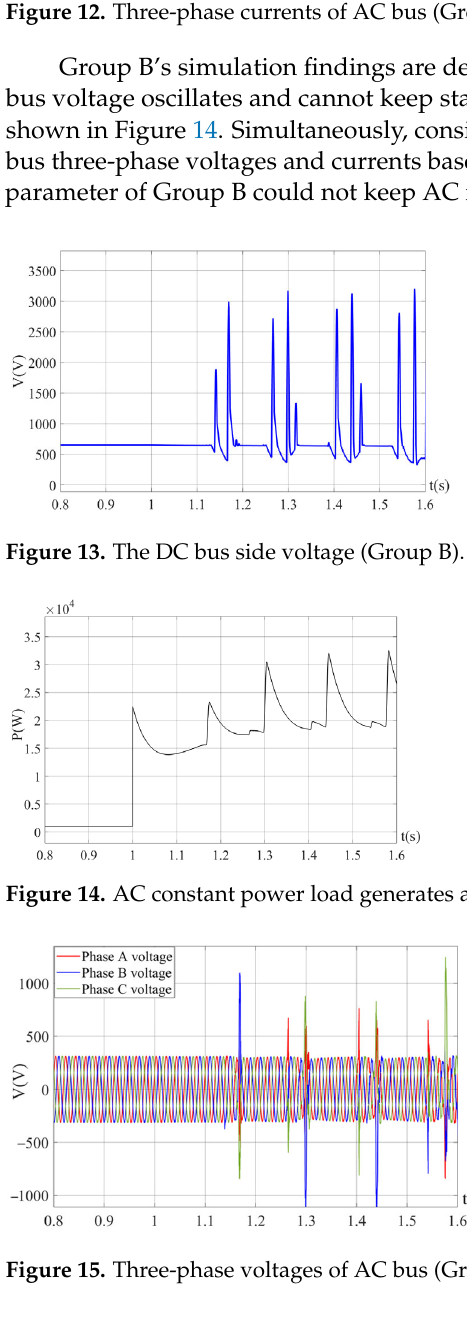
Figure 16. Three ‐ phase currents of AC bus (Group B). The simulation findings presented in Figure 9–16 demonstrate that energy storage converters employing the proposed stability control methodologies could maintain the stability of AC microgrids during major shocks. On the contrary, under the same disturb ‐ ances, energy storage converters do not follow stability control strategies leading to AC microgrid instability. These results prove the correctness of derived stability control strat ‐ egies in (29) and (33). 6. Experimental Results On the basis of the premise depicted in Figure 1, a model of an AC microgrid is de ‐ veloped to validate the stability control strategies derived for energy storage converters in (29) and (33). The energy storage system is coupled to the AC bus via bidirectional DC ‐ DC and DC ‐ AC converters, with DSP ‐ TMS320F28335 serving as the controller of the converters, as shown in Figure 17. The DC ‐ DC converter uses constant current control technology to maintain constant battery current. The charging and discharging states of a battery are automatically determined by comparing the actual DC voltage to a reference value. Ac ‐ cording to coordinate transformation, the DC ‐ AC converter utilizes a droop controller to achieve reference voltages and uses outer DC voltage control and inner AC current control methods. The rectifier of AC CPL uses a PI control strategy to ensure that the voltage value on both sides of the resistance is constant. Therefore, it can be approximated that the active power consumed by AC CPL is also constant. The input micro power supply is an AC power supply. Large signal interference can be achieved by introducing the step of AC CPL power. The AC microgrid’s parameters are listed in Table 3.